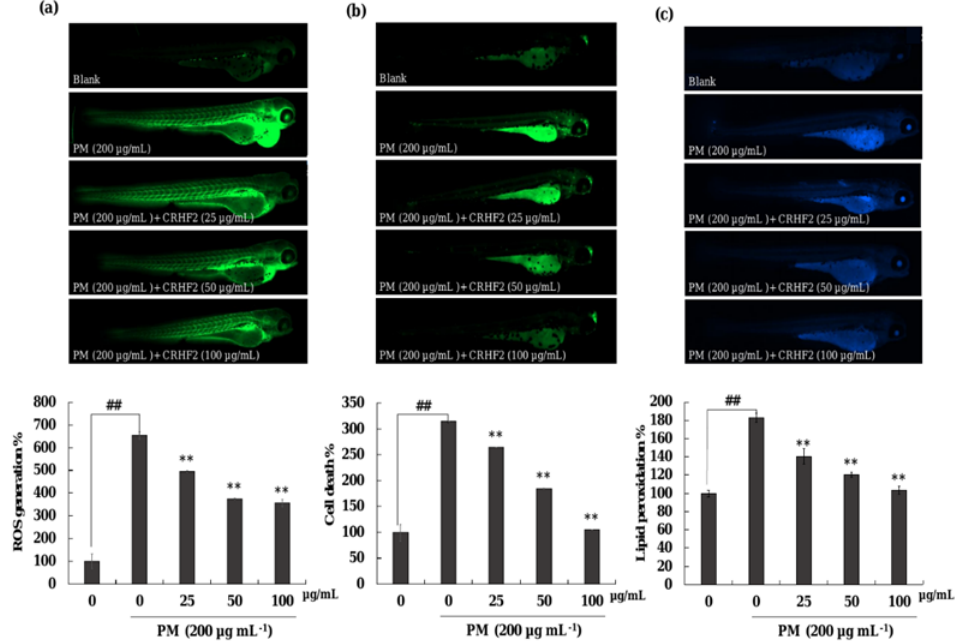
Figure 7. Protective effect of CRHF2 on PM-induced damage in zebrafish. ( a ) ROS production, ( b ) cell death, and ( c ) lipid peroxidation. Experiments were triplicated (n = 3). Results are represented as mean ± SD; ** p < 0.01. (# denotes significance compared to control while * represents significance compared to PM-treated group).